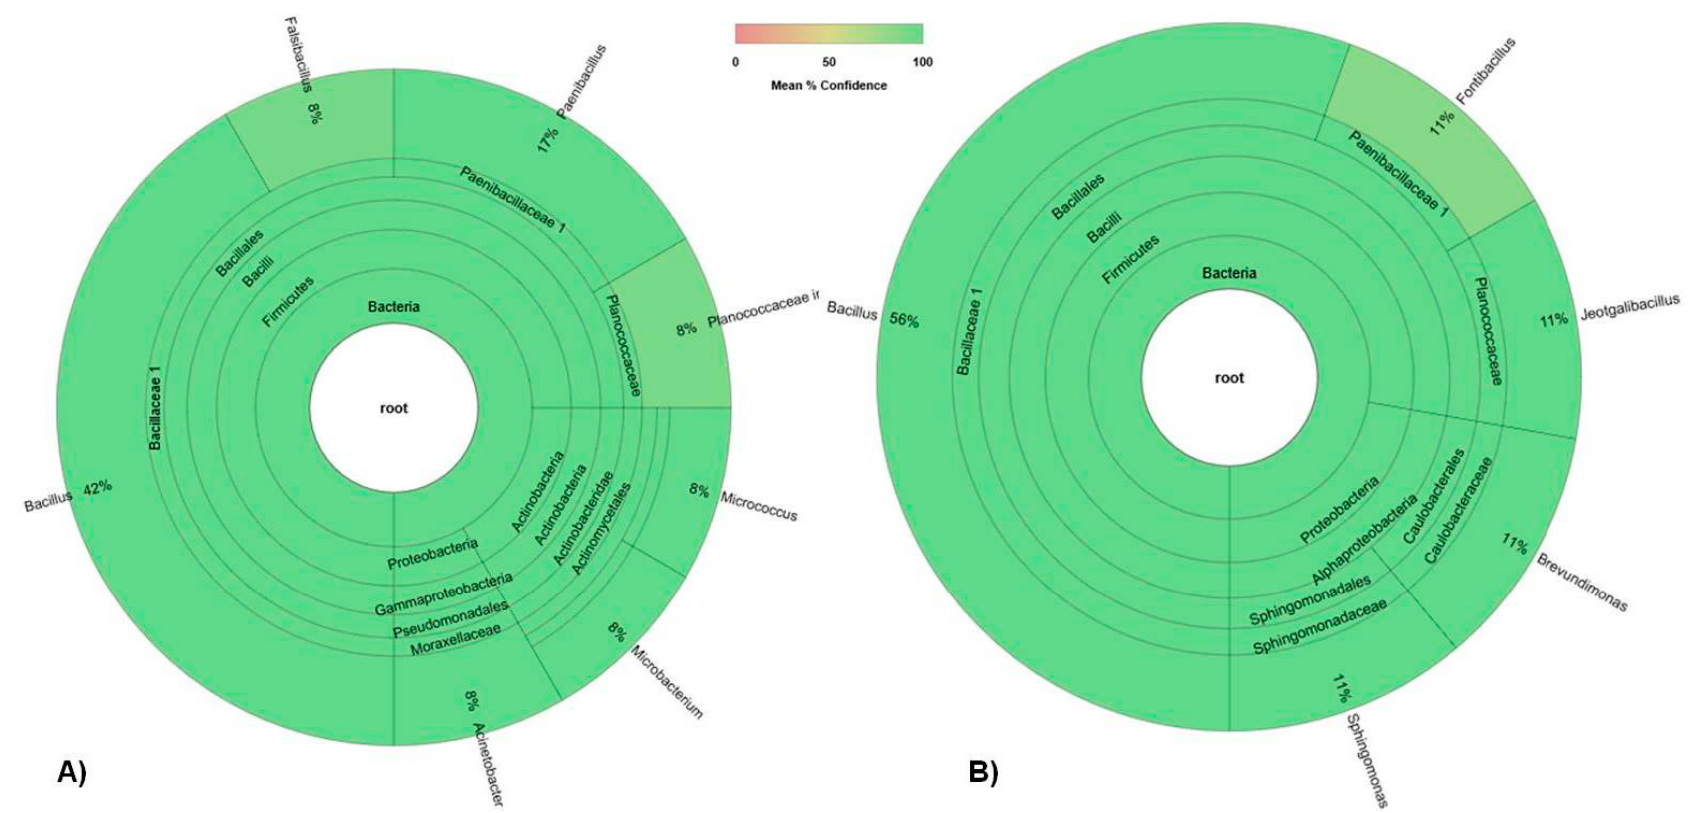
Figure A2. Comparison of bacterial species isolated from seeds and seedling of each tomato cultivar: ( A ) Elpida cultivar, ( B ) Silverio cultivar. 16S biodiversity graph generated with 16S Biodiversity tools of Genious software (version R9.0.5, Biomatters, http://www.geneious.com).